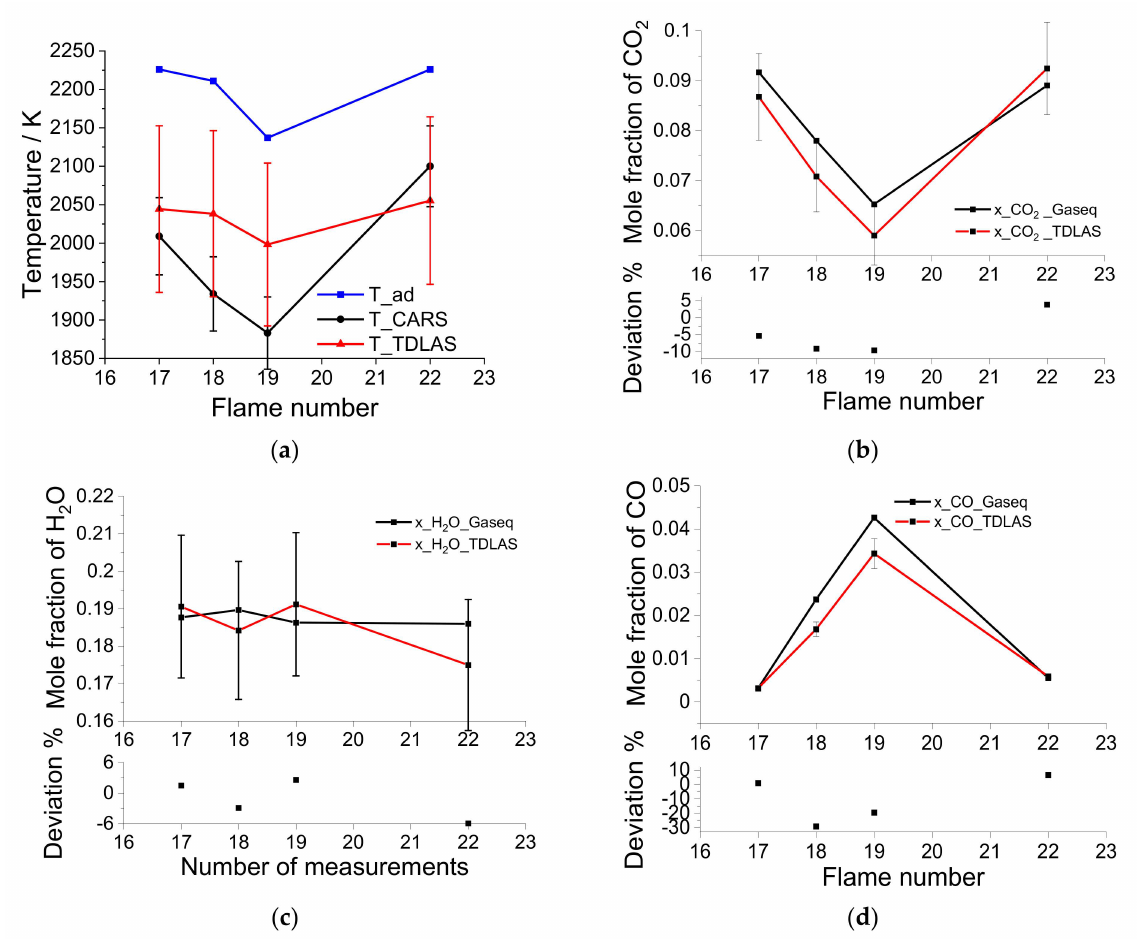
Figure 10. Measured temperatures ( a ) and concentration of CO 2 ( b ), H 2 O ( c ) and CO ( d ) in compar- ison to the temperatures measured by CARS and the simulated equilibrium concentrations from Ref. [34]. The measurement uncertainties for the CARS measurements were assumed to be 2.5% according to Ref. [34]. The measurement uncertainty for temperature measurements using two-line absorption thermometry with 1.4- µ m lasers is discussed in the relevant literature as being between 2.8% [7] and 6.7% [36]. In Ref. [29], the temperature deviation of identical burners is estimated at